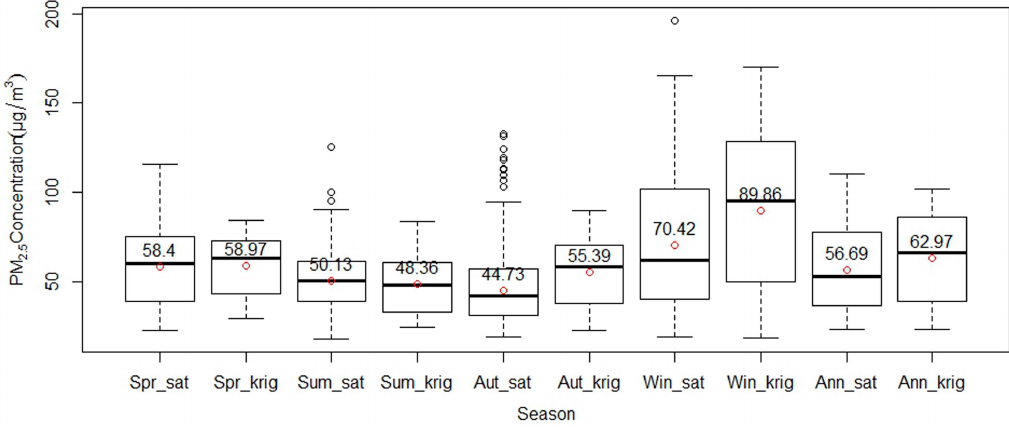
Figure 6. Statistical results of derived (_sat) and interpolated (_krig) PM 2.5 concentration maps. The mean values are shown as red circles, and the median marks and the midpoint are shown by the lines. The upper and lower quartiles (75th and 25th quantiles) represent 75% and 25% of the data, respectively, and the upper and lower whiskers represent the locations of the minima and maxima. Outliers are represented by black circles.